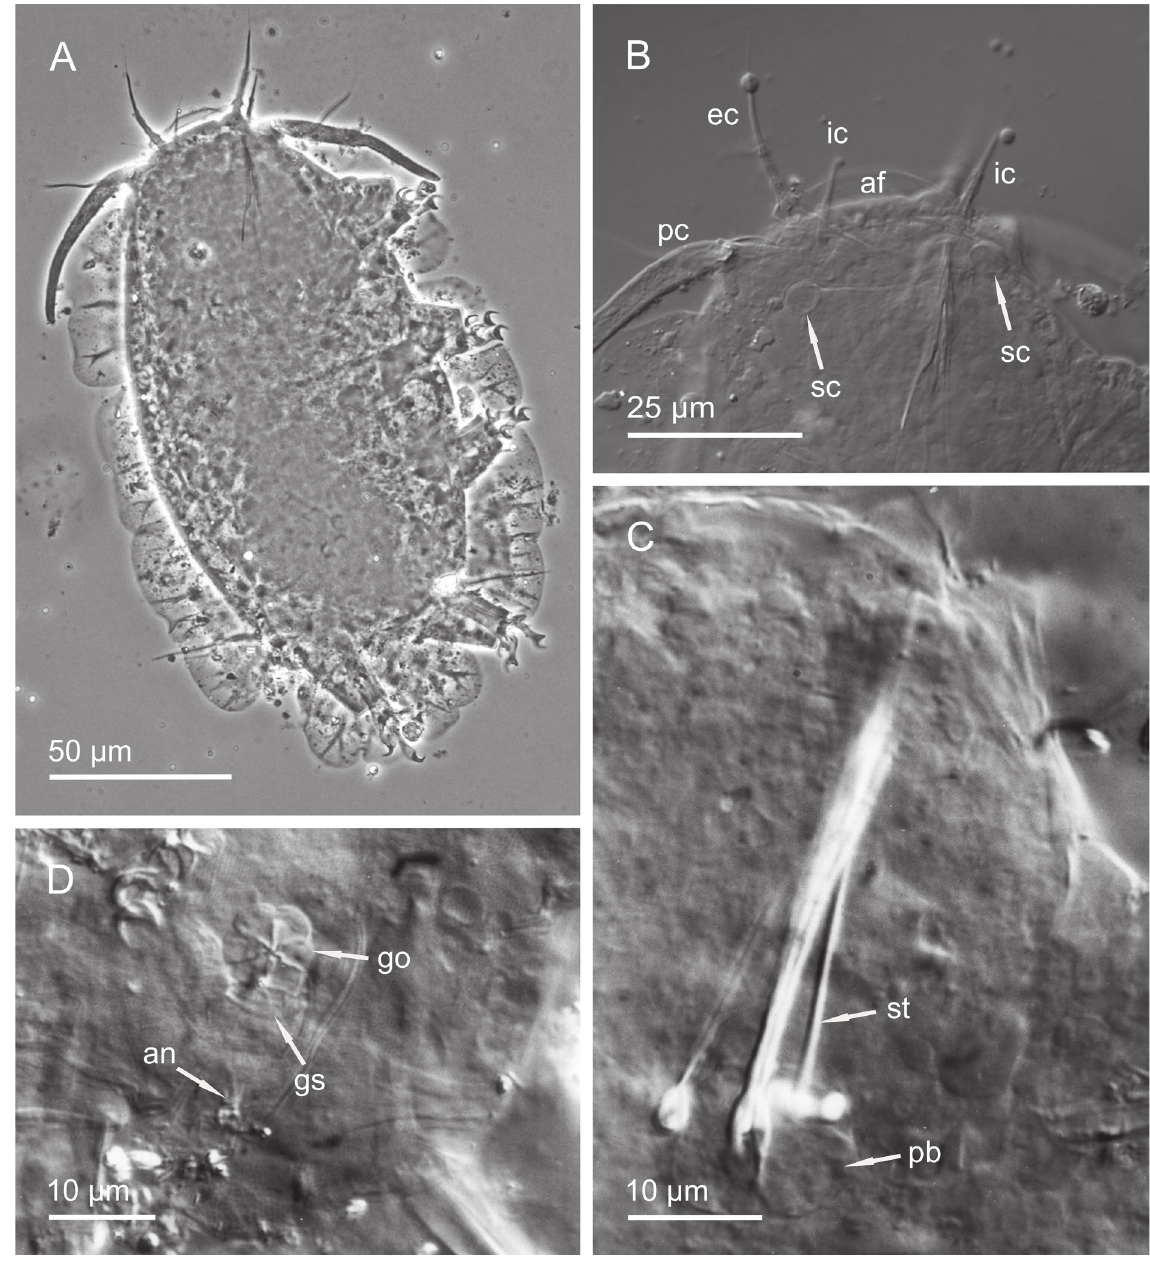
Fig. 13. Micrographs of Higginsarctus martini gen. et sp. nov., holotype, ♀ (NHMD-293903). A . Overview (PhC). B . Close up on the head (DIC), ventral view showing the cephalic cirri and secondary clavae. C . Close up on the bucco-pharyngeal apparatus (DIC). D . Close up on the caudal region (DIC), ventral view showing the gonopore, genital stoup and anus. Abbreviations: see Material and